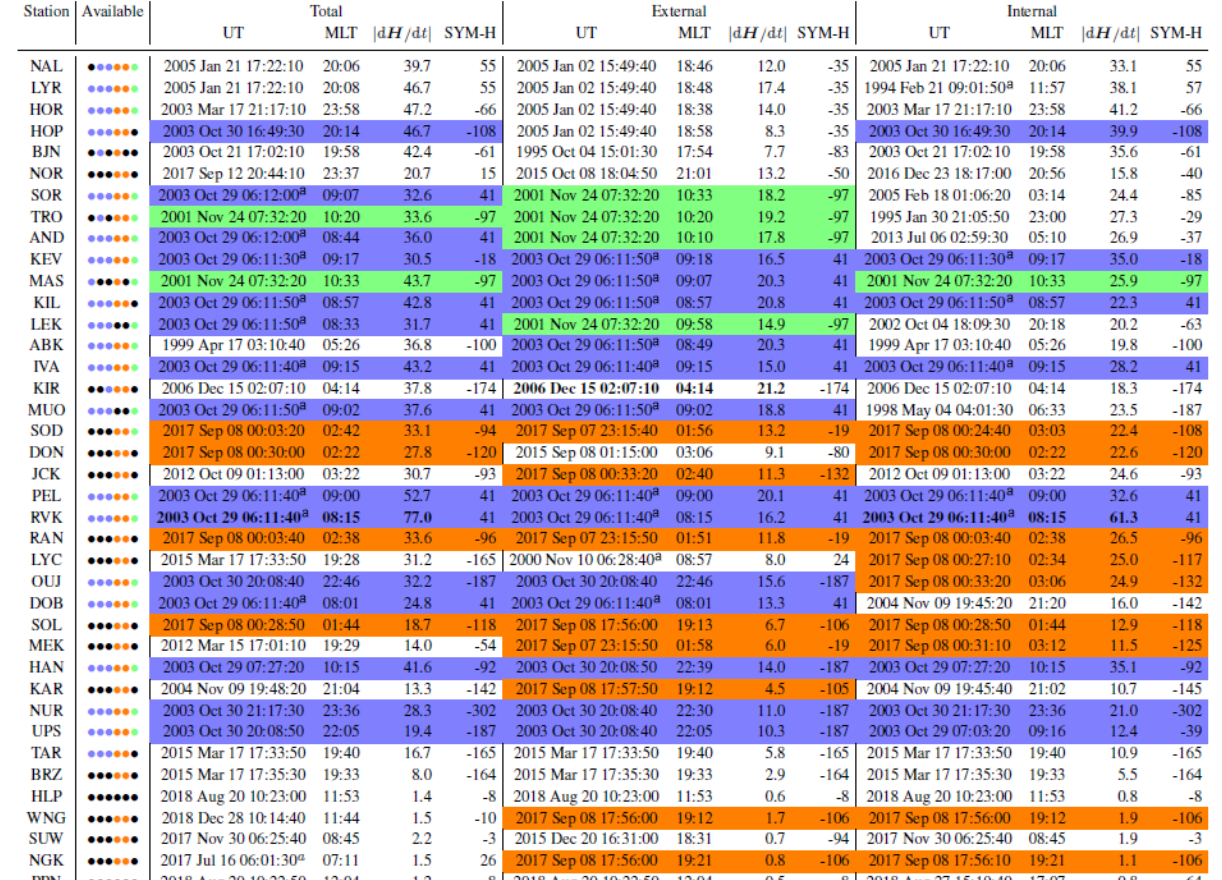
Table 1. Maximum total (external + internal), external (ionospheric and magnetospheric), and internal (telluric) time derivative of the hor- (cid:113) ( d B x / d t) 2 + ( d B y / d t) 2 [nTs − 1 ]) at IMAGE stations between 1994 and 2018. Magnetic local izontal ground magnetic field ( | d H / d t | = time (MLT) [HH:MM] has been calculated using https://apexpy.readthedocs.io/en/latest/, last access: 22 December 2022. SYM-H [nT] has been obtained from https://spdf.gsfc.nasa.gov/pub/data/omni/high_res_omni/, last access: 22 December 2022. Colors: Event 1: 29–31 Octo- ber 2003 in purple, Event 2: 7–8 September 2017 in orange, and Event 3: 24 November 2001 in green. Colored dots in the second column indicate station availability during the days of the events (black: not available). The absolute maximum total, external, and internal | d H / d t | in bold.